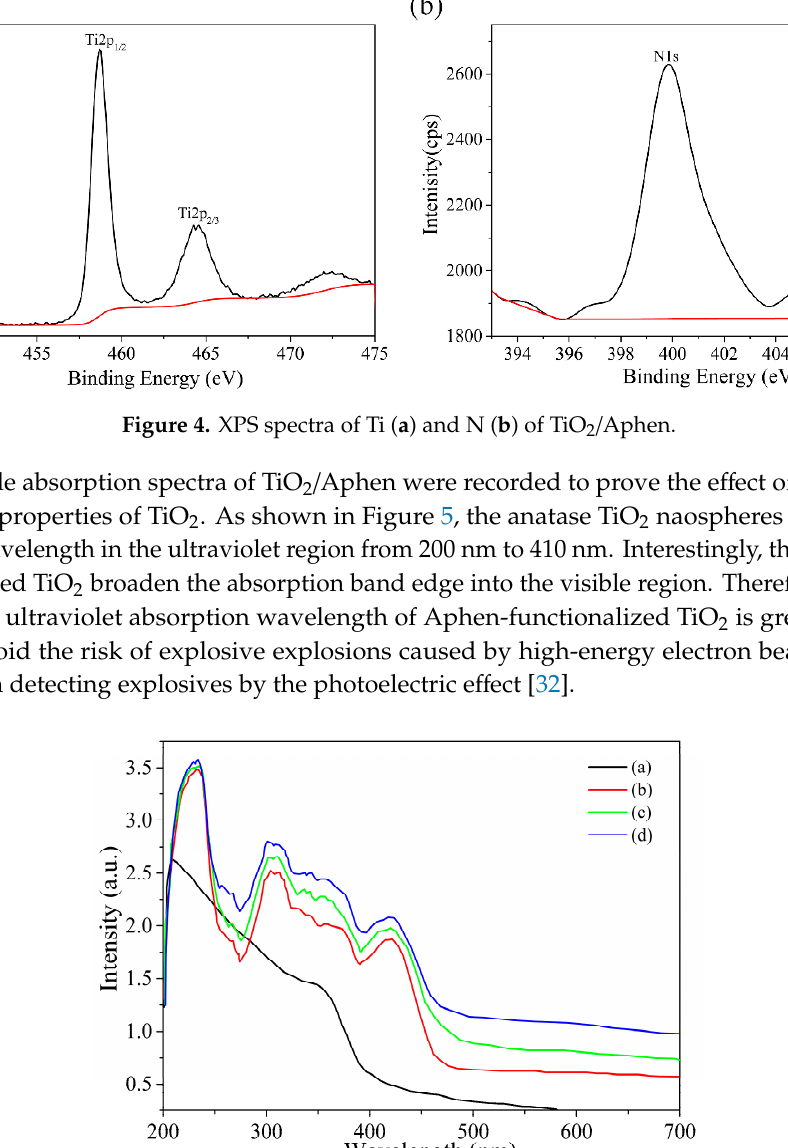
Figure 3. FTIR spectra of Aphen, TiO 2 , and TiO 2 /Aphen (1:200).